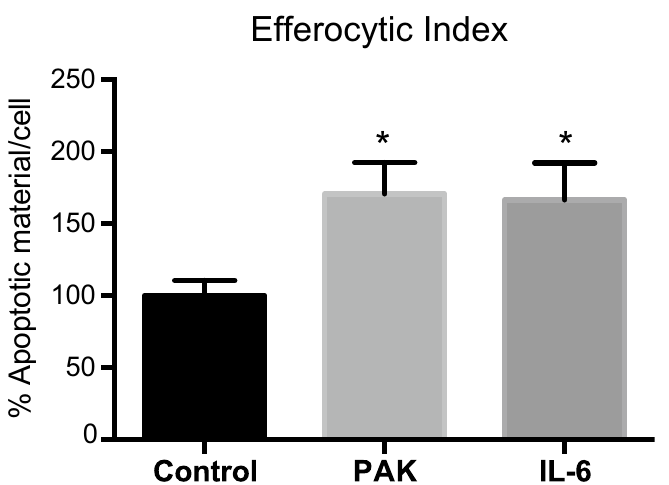
Figure 5. BMDM Efferocytic Index is increased by IL-6 pre-stimulation. BMDM Efferocytic Index after pre- stimulation with PAK or IL-6 (10 ng/ml). BMDM (from C57BL/6J mice) were incubated for 50 min with PAK or IL-6, and non-stimulus as Control. The efferocytic capacities using apoptotic cells as targets were checked 18 h after pre-stimuli. Data were normalized to the Control (non-stimulus: 100%) and expressed as mean of apoptotic material/cell ± SEM of two independent experiments. *p < 0.03 vs. Control by unpaired t